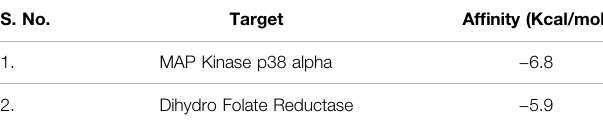
TABLE 1 | CIN ’ s binding af fi nity with MAP kinase p38 alpha and DHFR. S. No.